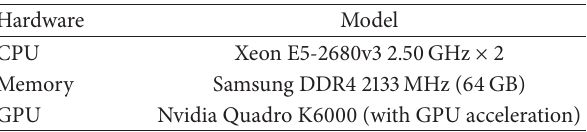
Table 6: Configurations of